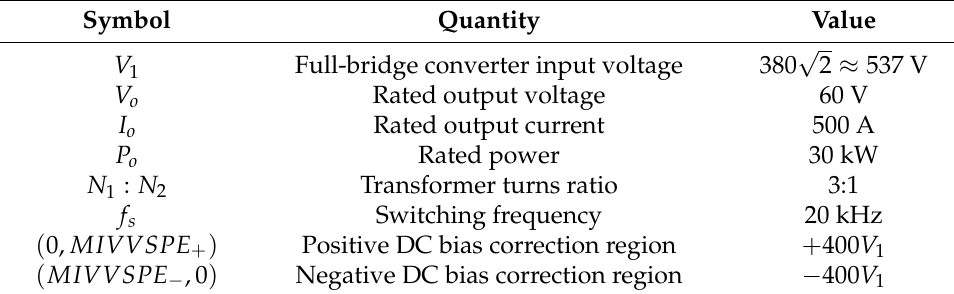
Table 2. The main parameters of the arc welding